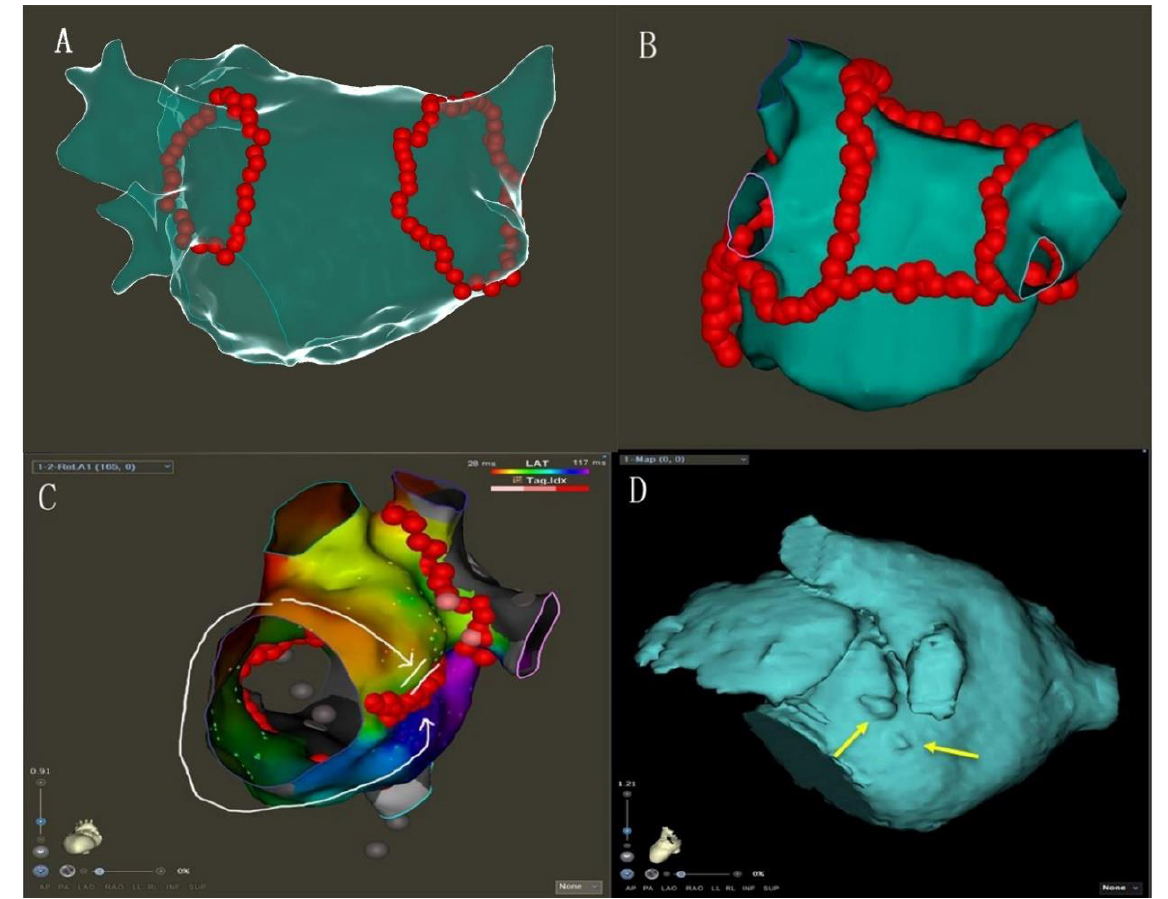
Figure 1. ( A ): Circumferential isolation of both ipsilateral pulmonary veins. ( B ): Typical recording of PVI-plus linear ablation of MI, LA roof and posterior inferior (posterior box isolation). ( C ): Conduction block of MI ablation line was examined by activation mapping: Mitral isthmus ablation line with bidirectional block (white arrow). ( D ): Typical MI pouches (indicated by yellow arrows) were observed in three-dimensional anatomical model.